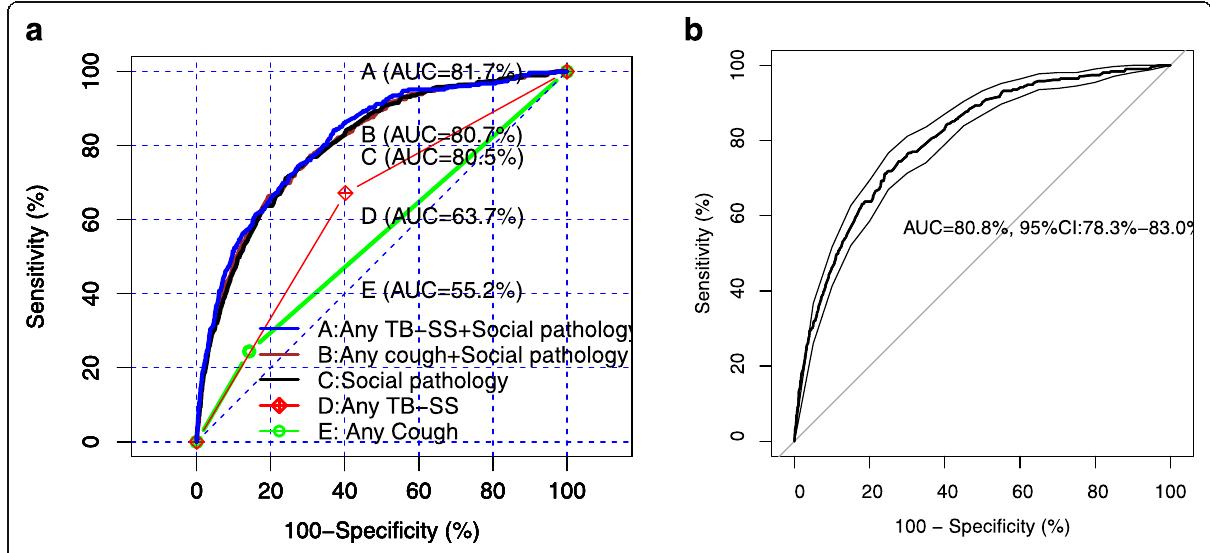
Fig. 3 a ROC curve of various TB screening models A to E. b ROC curve of validated data of social pathology model C (Bootstrap resampling=500)